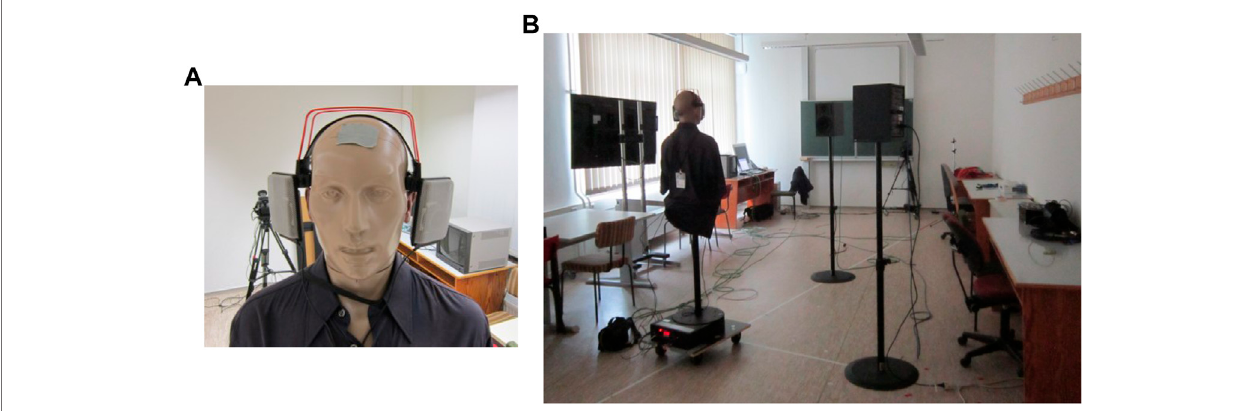
FIGURE1 | (A) AKG K1000 headphones opened by 45 ° are placed on the Kemar 45BA ’ s ears. (B) Setup for the BRIR measurementin the chosen seminar room.